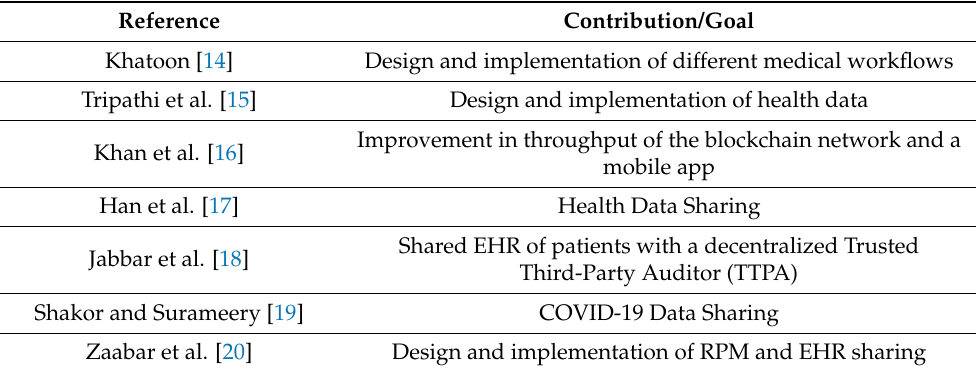
Table 1. Summary of related